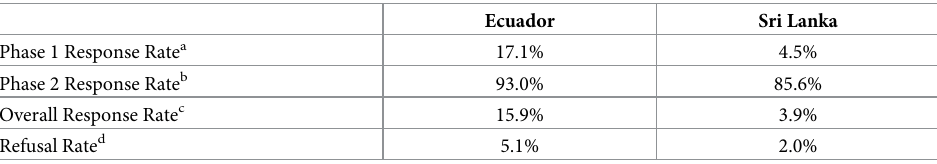
Table 2. Response